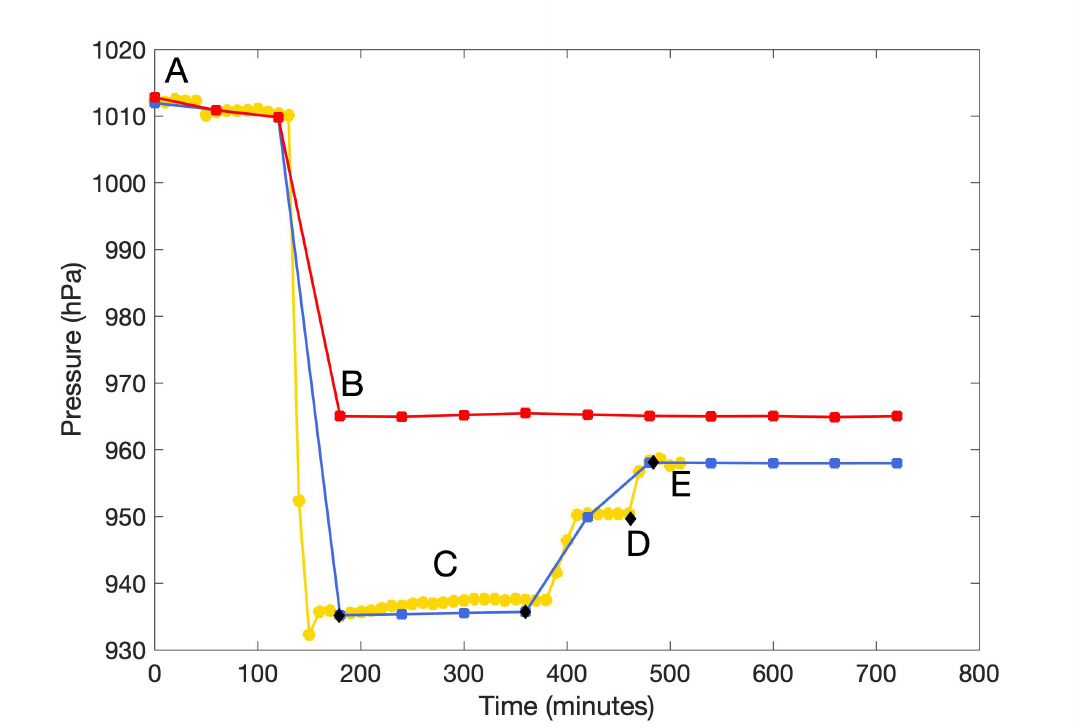
Figure 8. Barometric pressure data from GLOF buoy A (blue line), buoy B (red line), BaroDiver